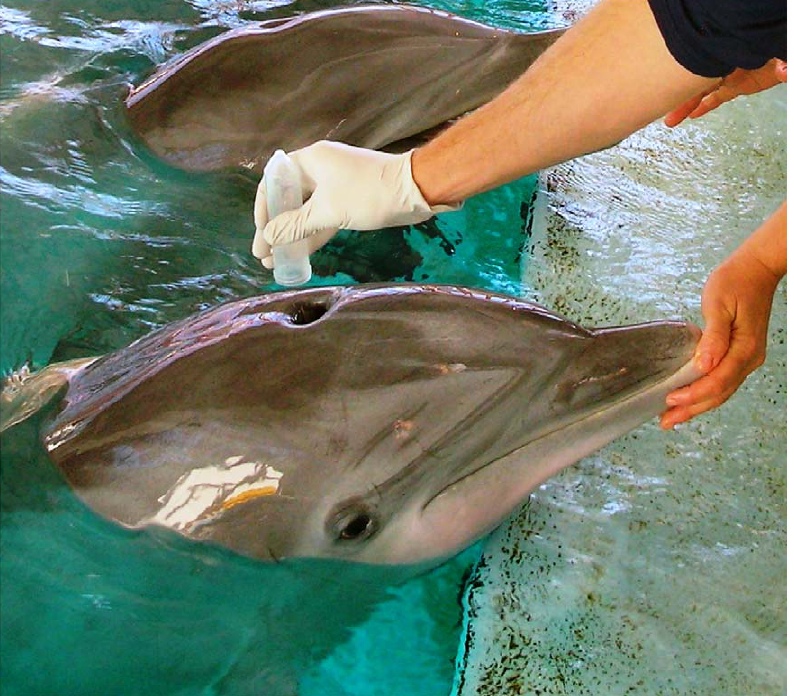
Figure 1. Blow sample collection using sterile 50 ml polypropylene tubes. A test tube was held inverted over the dolphin’s blowhole and the dolphins were trained to exhale on cue (Figure 1). Four to six exhalations were collected per tube. We collected two sets of blow samples from each individual using sterile 50 ml polypropylene tubes (Fisherbrand) to test two different storage and transportation methods (detailed below). Both sets of blow samples were stored on dry ice for transportation to Georgetown University (Washington DC, USA). Once in the laboratory, the first set of blow samples were resuspended in 1 ml of 100% ethanol. The sides were scraped down using sterilized policemen, vortexed, and finally centrifuged at 3000 rpm for 3 minutes. Samples were then transferred to 1.5 ml microcentrifuge tubes to dry off the ethanol in a speed vacuum. The second set of blow samples were resuspended in 500 m l of TE buffer and centrifuged at 3000 rpm for 3 minutes. Excess TE buffer was carefully removed from all samples leaving a small amount at the bottom of the tube. DNA extraction of both sets of blow samples and blood samples were completed using a Qiagen DNeasy Blood and Tissue kit, using the animal tissues spin-column protocol. After DNA purification, blow samples were stored at 2 80 u C until transportation to the University of Queensland (Brisbane, Australia) for DNA fingerprinting. A control sample of seawater was taken along with each blow sample set to assure that any DNA results were from blow samples and not seawater contamination.